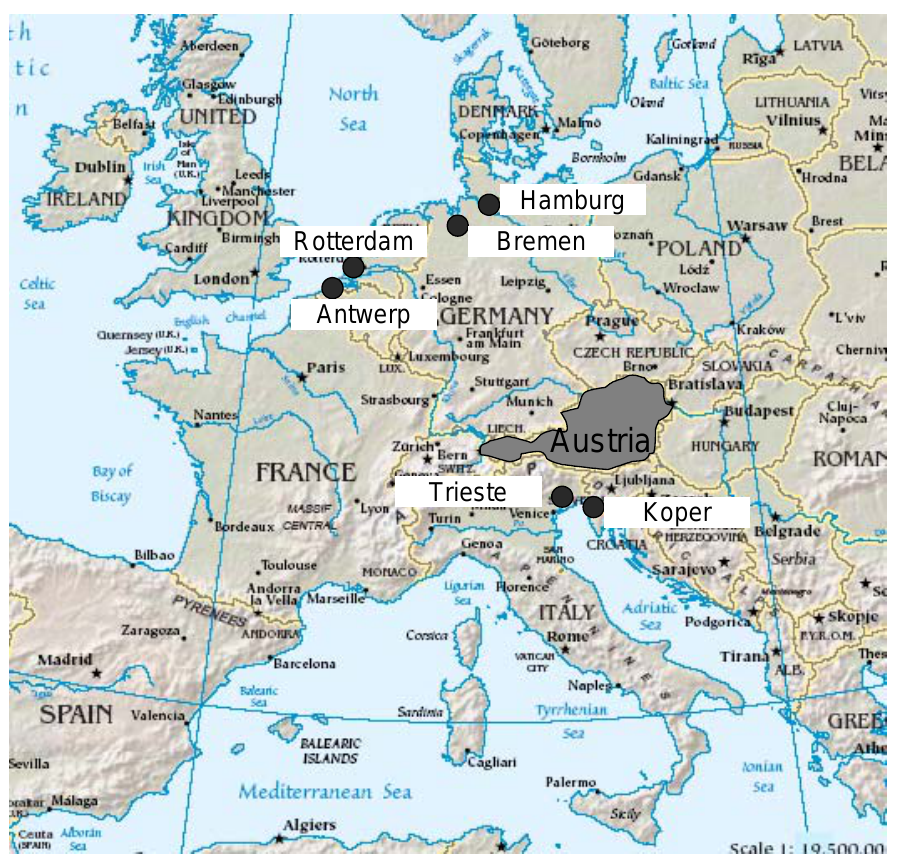
Figure 2. The main seaports serving Austria The volumes of overseas imports and exports and their distribution over ports in 2003 are given in table